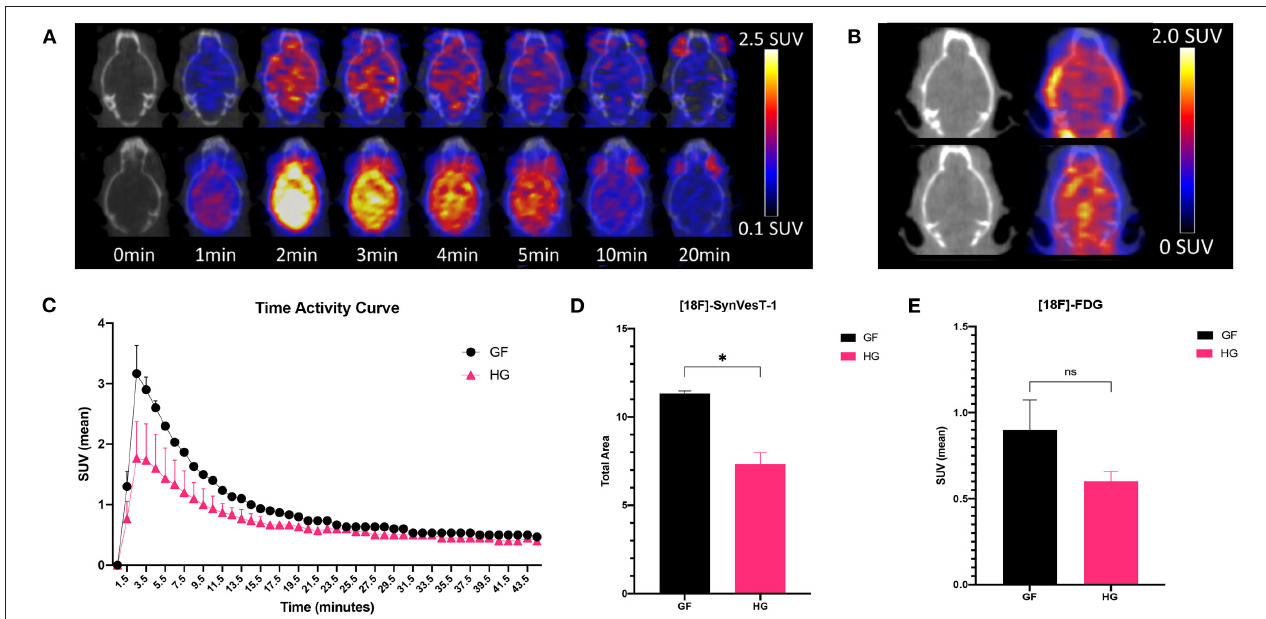
FIGURE 2 | (A) Fused axial PET/CT images of male P90 HG (top row) and GF (bottom row) mice following the injection of 18 F-SynVesT-1 demonstrating the qualitative higher uptake of the SynVesT-1 radiotracer in GF mice. (B) Static 18 F-FDG images of HG (top row) and GF (bottom row). (C) Time-activity curves (mean ± SD) of male GF and HG P90 mice. The area under the curve was calculated for the peak stabilized interval (4.5–10.5min) for 18 F-SynVesT-1 (D) and 18 F-FDG (E) . HG, humanized gnotobiotic mice; GF, germ-free; * p < 0.0 5.